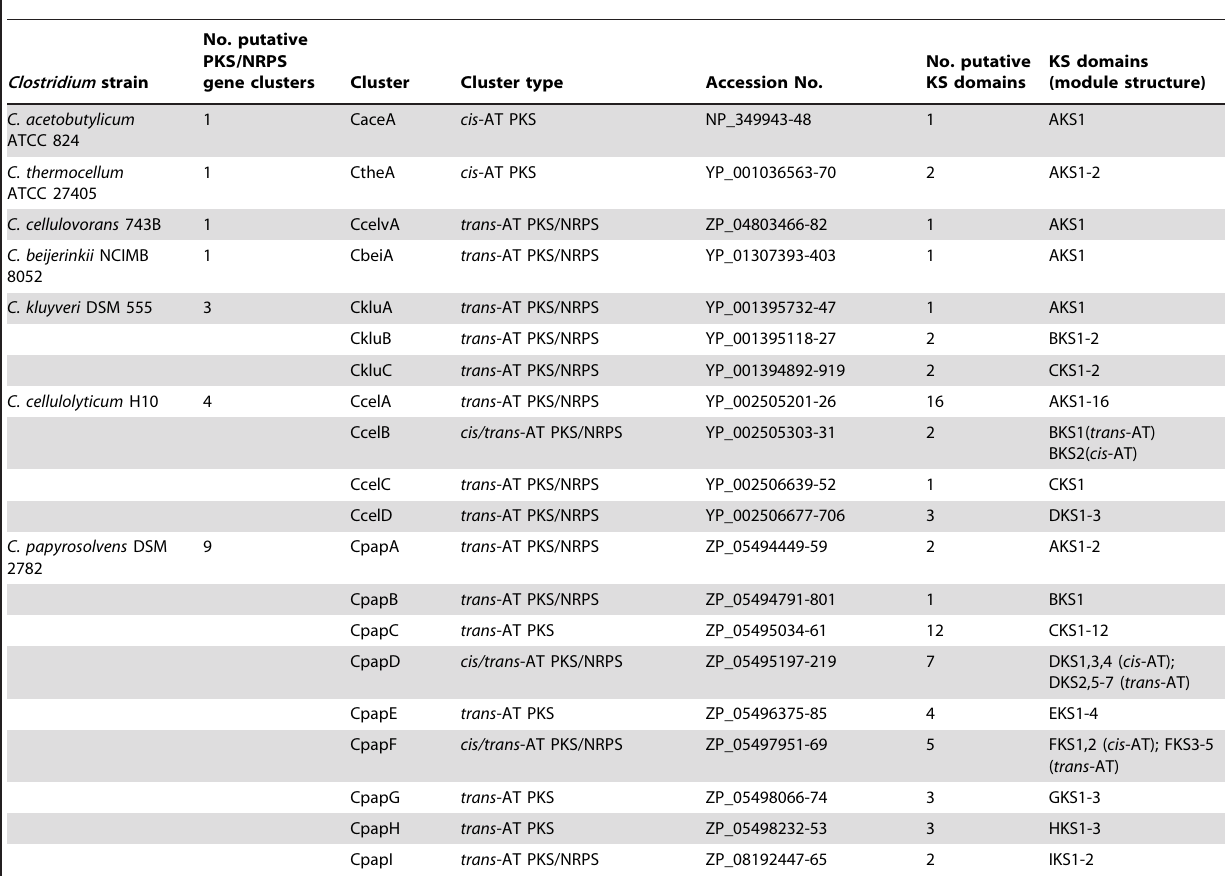
Table 1. Putative PKS/NRPS gene clusters in sequenced Clostridium